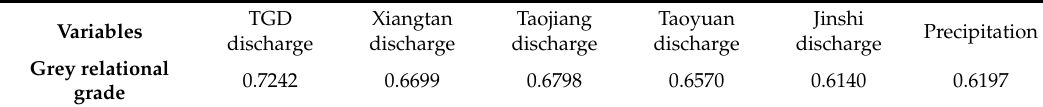
Table 1. GRA results.